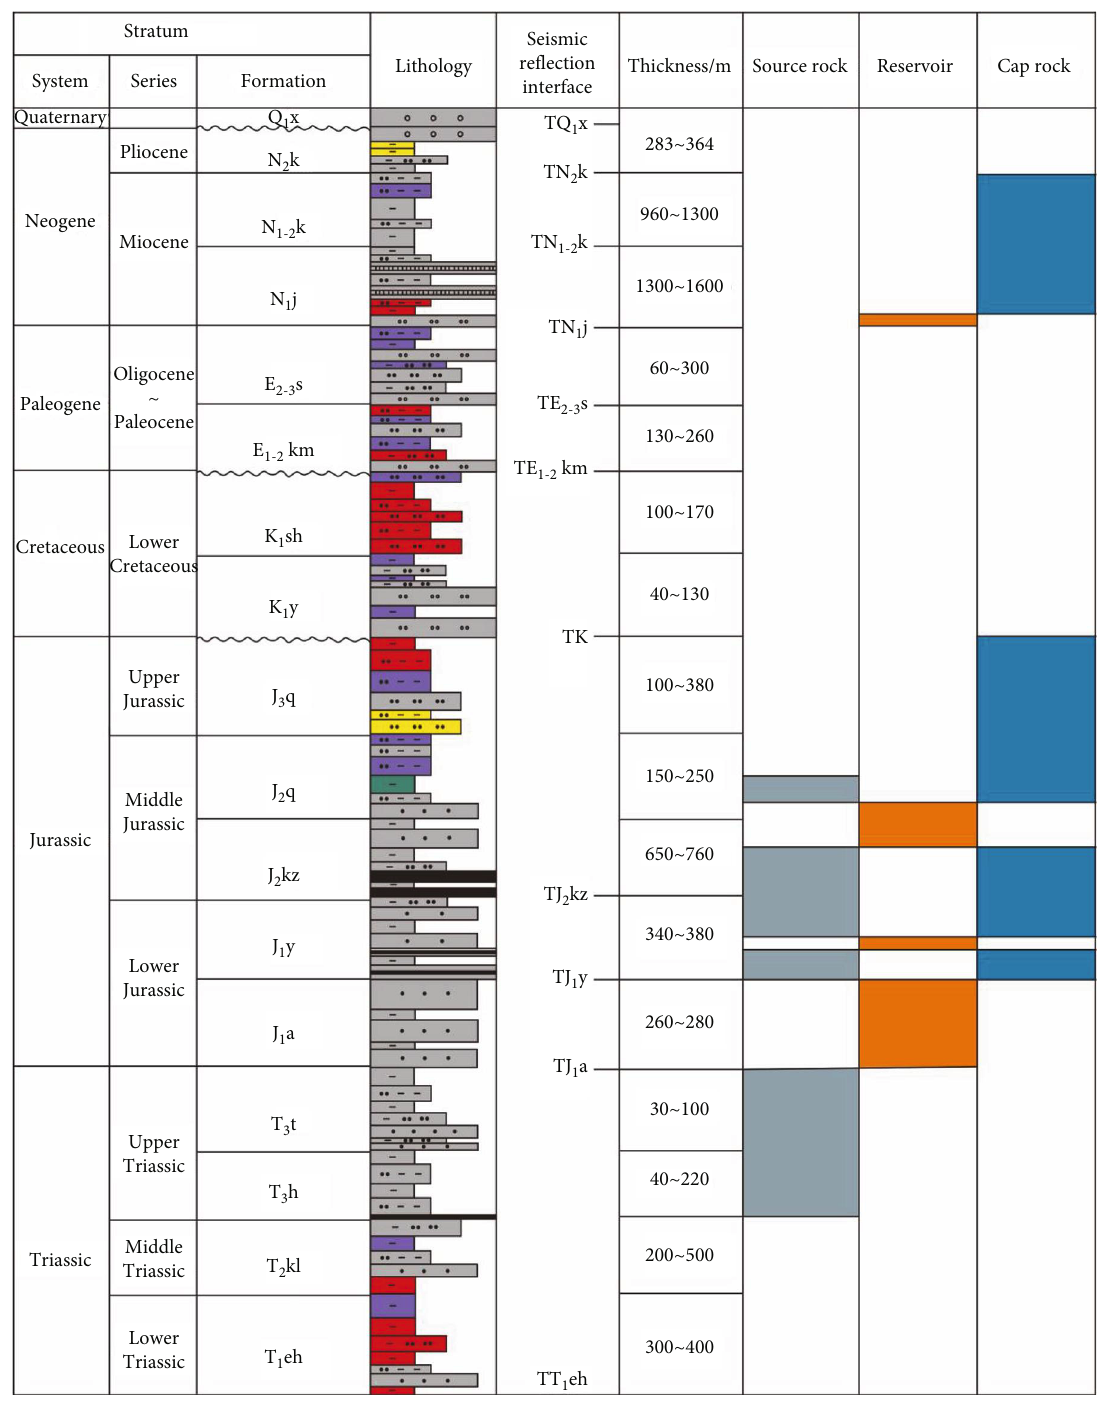
Figure 3: Mesozoic Cenozoic stratigraphic system in the northern tectonic belt of the Kuqa Depression